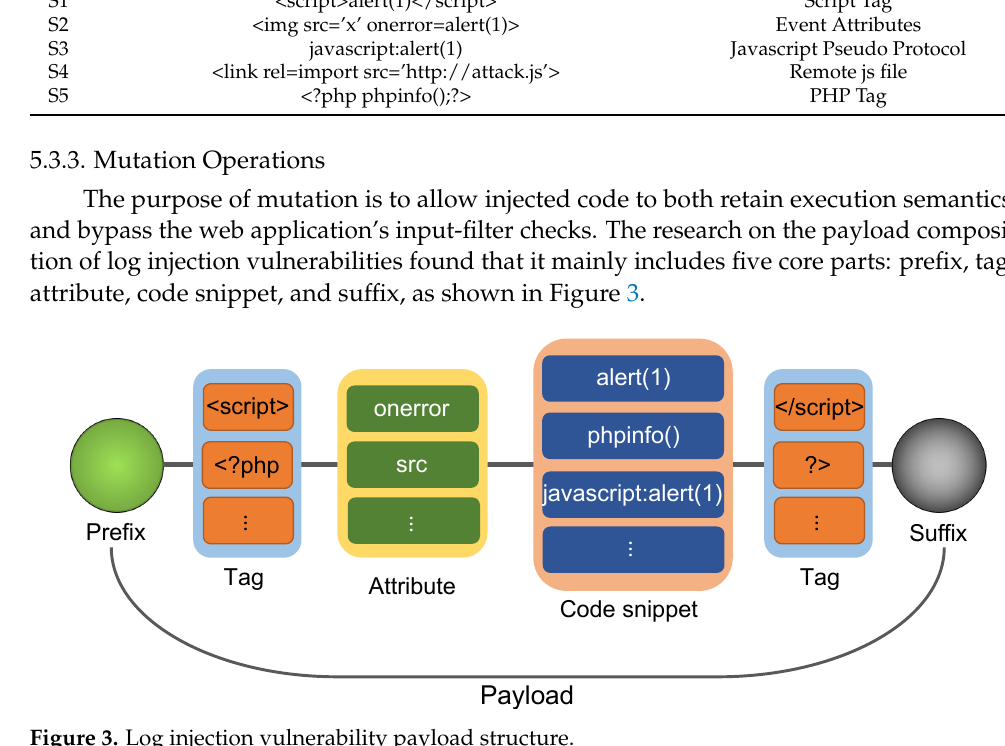
Figure 3. Log injection vulnerability payload